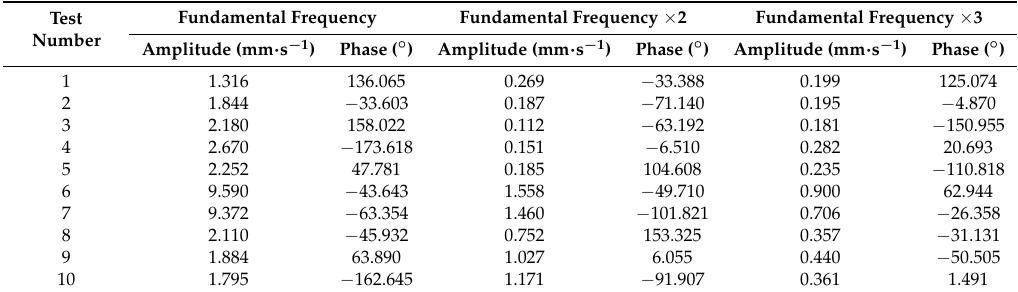
Figure 22. Time domain waves and FFT spectra of the vibration signal belonging to sensor point 3H: ( a ) the time domain wave of Test No. 2, ( b ) Fourier spectra of Test No. 2, ( c ) the time domain wave of Test No. 4, ( d ) Fourier spectra of Test No. 8, ( e ) the time domain wave of Test No. 8, ( f ) Fourier spectra of Test No. 8, ( g ) the time domain wave of Test No. 10, ( h ) Fourier spectra of Test No. 10. Table 6. Corrected information of frequency, amplitude, and phase using the proposed AFSSC.